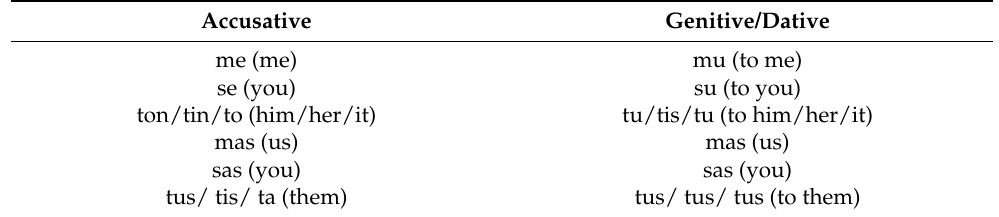
Table 1. The paradigma of the clitics in